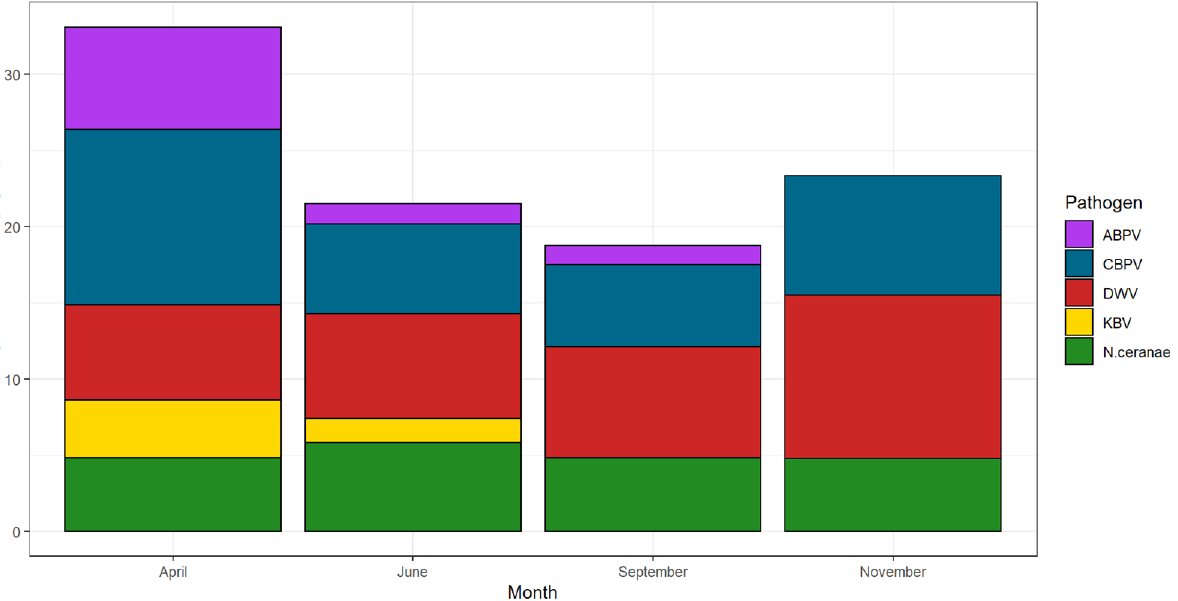
Figure 6. Abundance of each considered pathogen over the year. For a better visualization, data are shown as decimal logarithms. Means are indicated by red dots. Different letters denote significant differences between months.